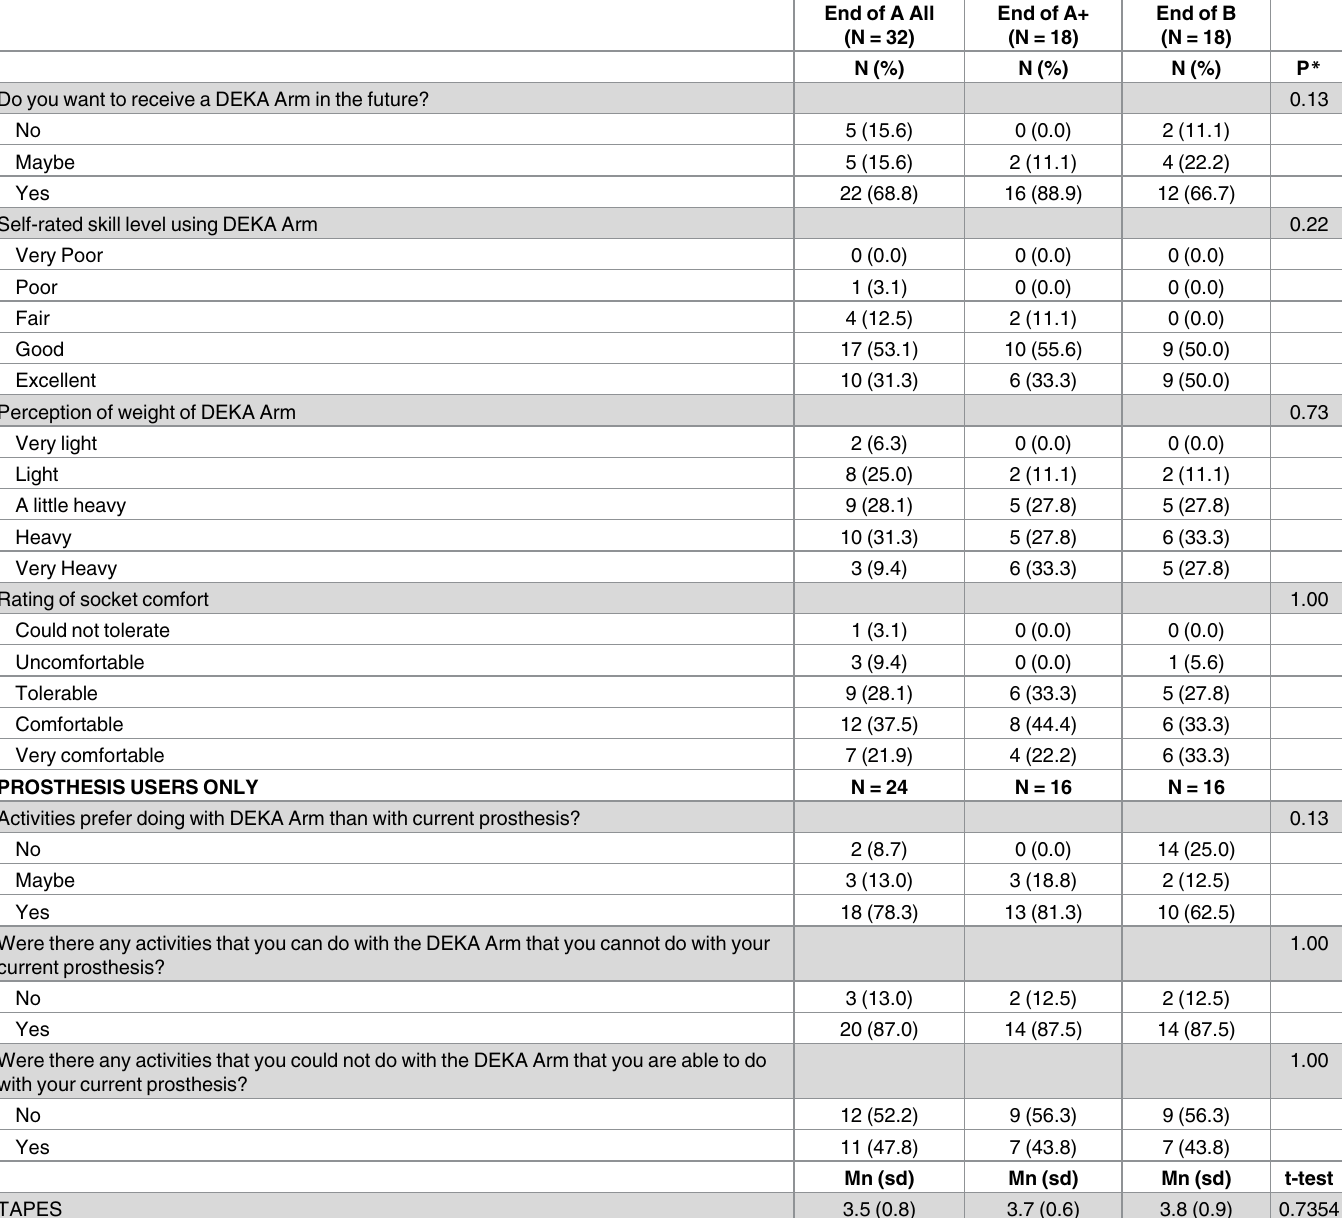
Table 2. Survey items administered at End of A and End of